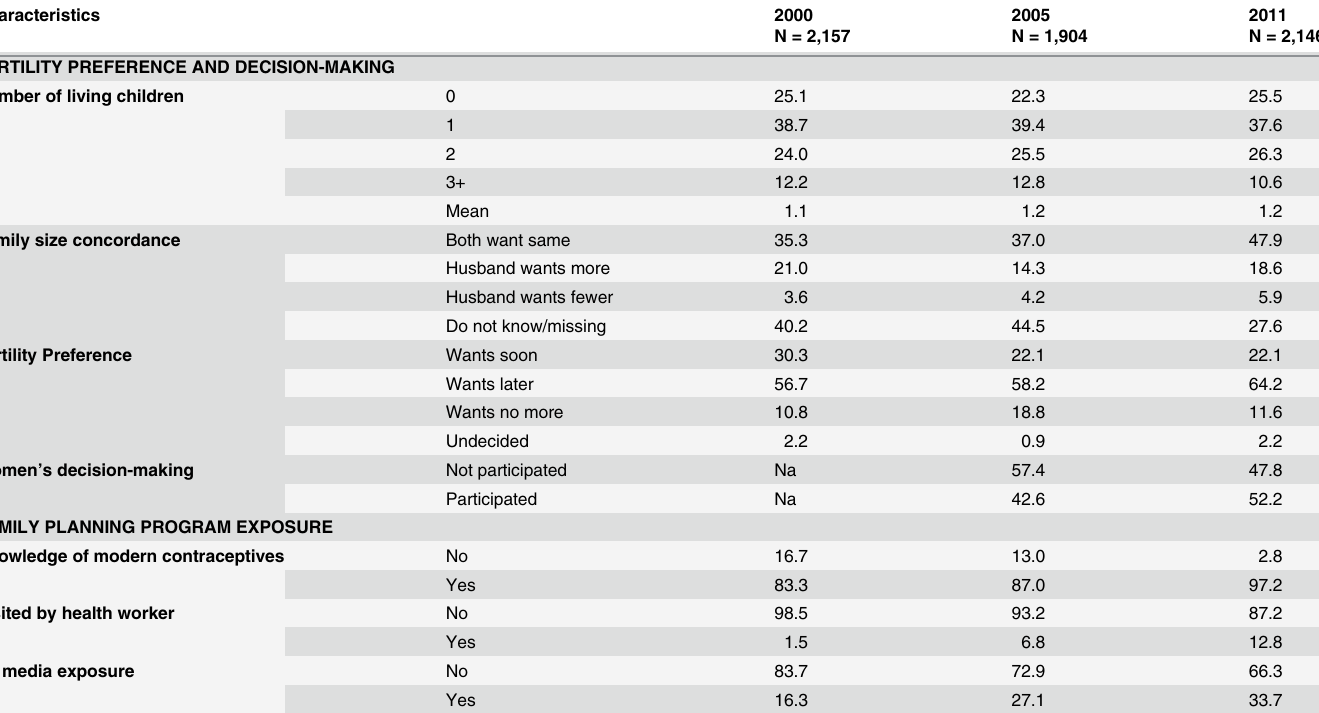
Table 2. Percentage distribution of fertility preference and family planning program exposure of the respondents, 2000, 2005, and 2011 Ethiopia Demographic and Health Surveys. Characteristics